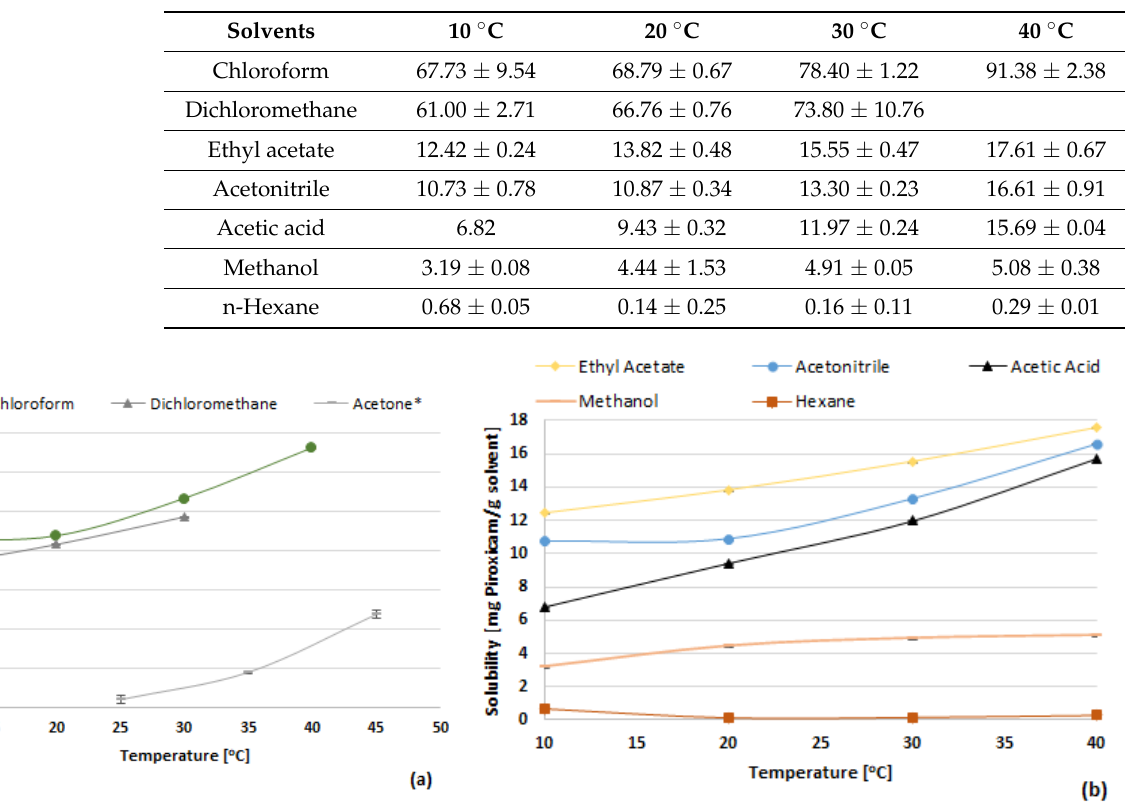
Figure 1. (2-column fitting) Solubility of piroxicam form II in different solvents. Solid lines are drawn for visual guidance. ( a ) Solubility of piroxicam in chloroform, dichloromethane and acetone. ( b ) Solubility of piroxicam in ethyl acetate, acetonitrile, methanol, hexane and acetic acid. * Acetone solubility was obtained in an earlier study [9]. Table 1. Solubility of piroxicam form II in different solvents at varied temperatures (in mg/g sol- vent).